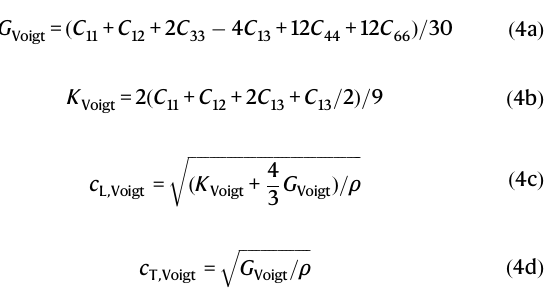
ffiffiffiffiffiffiffiffiffiffiffiffiffiffiffiffiffi q ð 4d Þ G = ρ Voigt